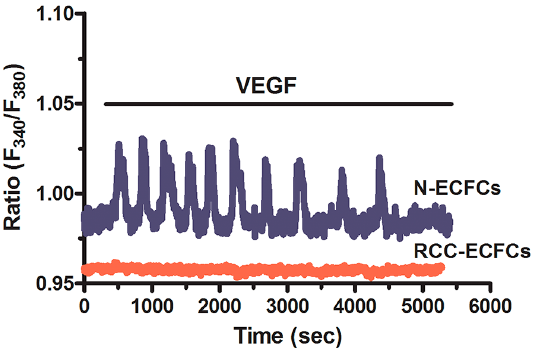
Figure 3. VEGF does not trigger pro-angiogenic Ca 2+ oscillations in tumor-derived endothelial colony forming cells. VEGF (10 ng/mL) triggers intracellular Ca 2+ oscillations in N- ECFCs, but not in RCC-ECFCs. Adapted from [95].